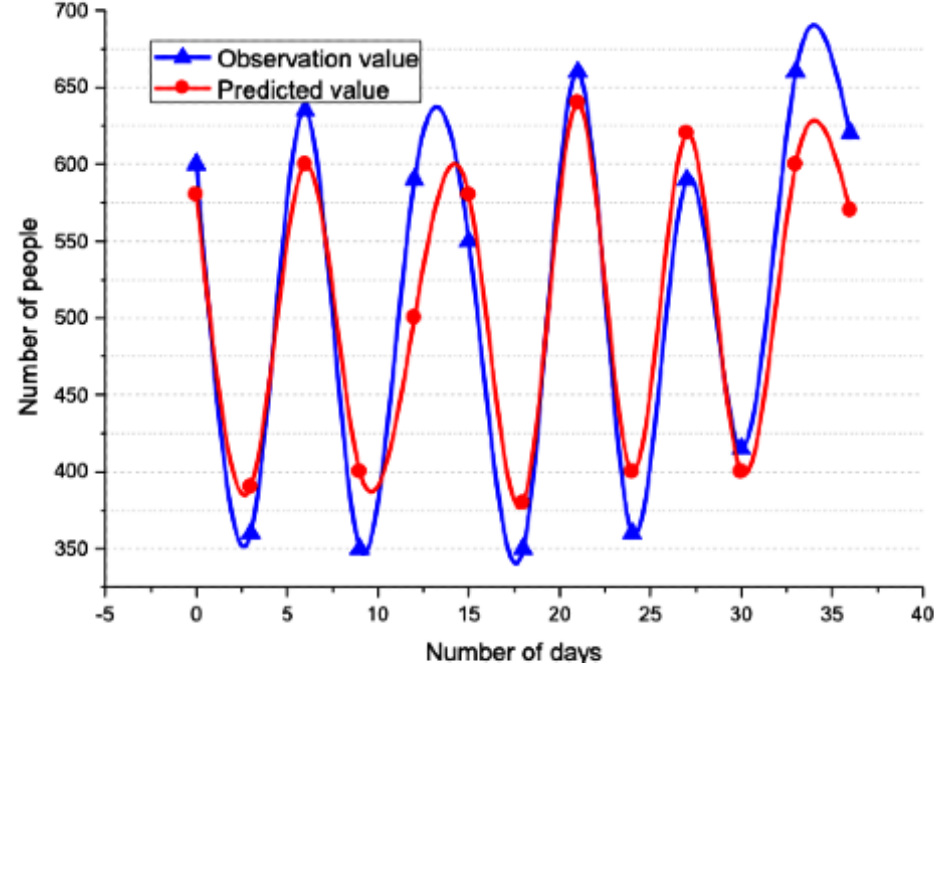
Figure 5. Daily outpatient volume forecast